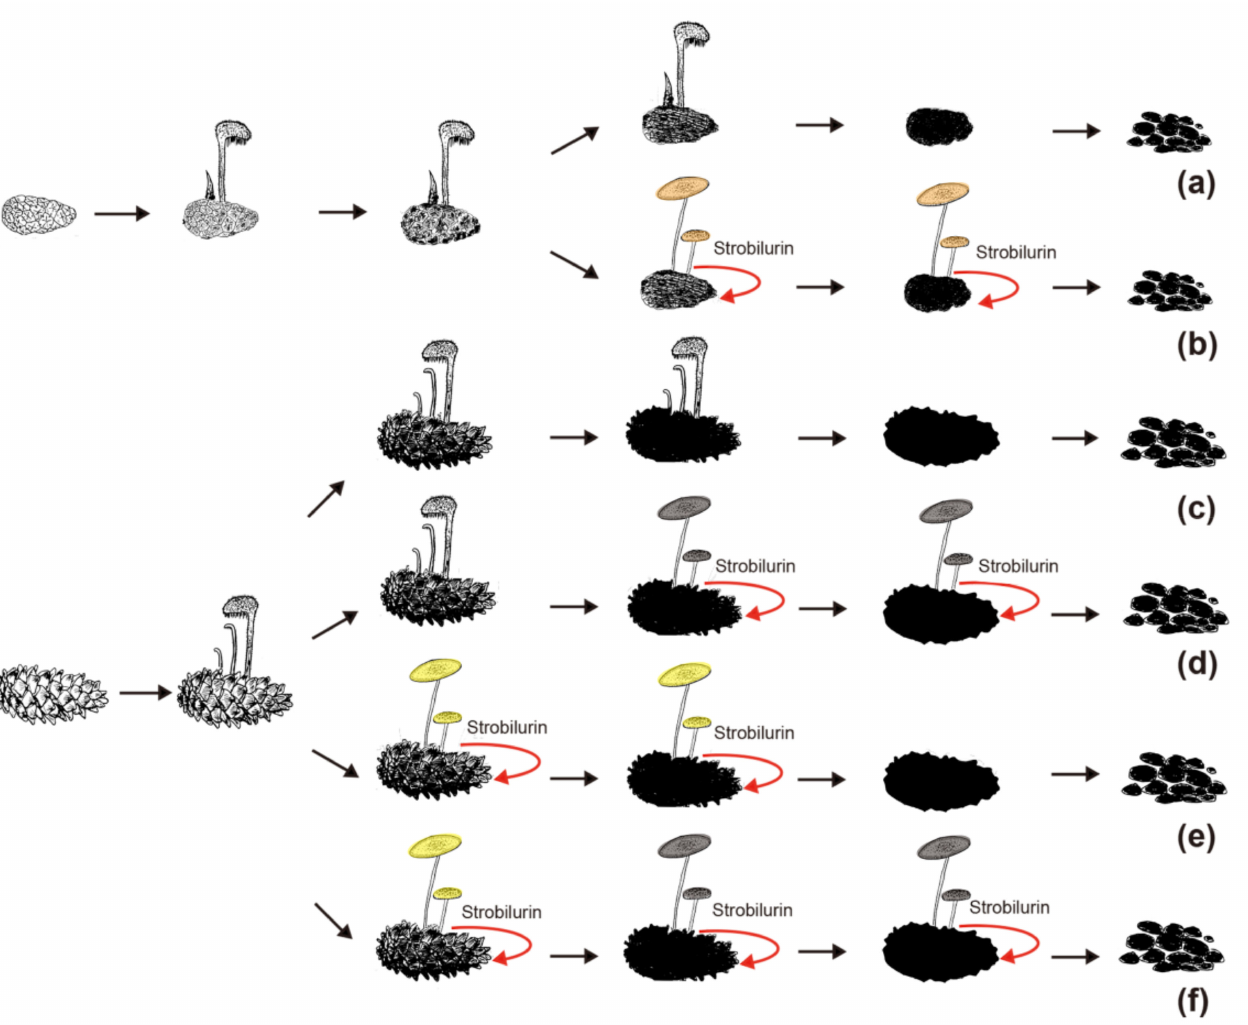
Figure 6. Types of successive decomposition of pinecones observed in the field. ( a , b ) The decomposition of cones of P . subgenus Pinus . ( a ) The cones decomposed by A. vulgare or A. orientale independently. ( b ) Successive decomposition and competition of A. orientale / S. luchuensis and A. vulgare / S. stephanocystis on cones of P . subgenus Pinus . The yellow brown pileus represents S. luchuensis or S. stephanocystis . ( c – f) The decomposition of cones of P. subgenus Strobus . ( c ) The cones decomposed by A. microsporum independently. ( d ) Successive decomposition and competition of A. microsporum and S. orientalis on cones of P . subgenus Strobus . The gray brown pileus represents S. orientalis. ( e ) Successive decomposition and competition of A. microsporum and S. pachcystidiatus on cones of P . subgenus Strobus . The yellow pileus represents S. pachcystidiatus . ( f ) Successive decomposition and competition of A. microsporum , S. pachcystidiatus and S. orientalis on cones of P . subgenus Strobus